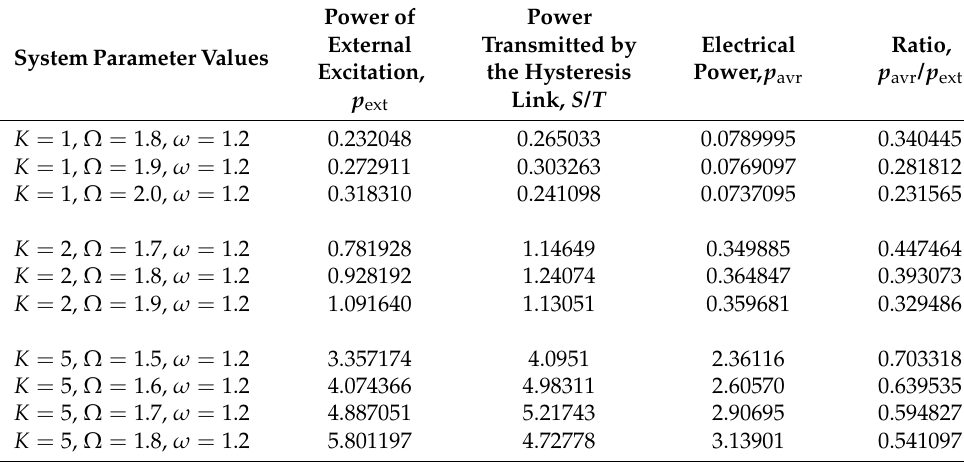
Table 2. Power values at H =